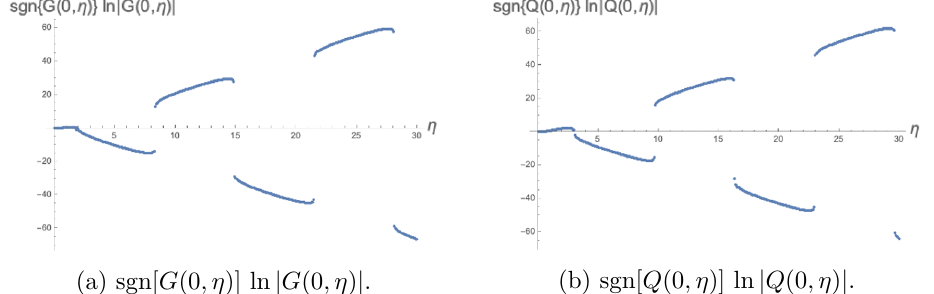
Figure 3 . Plots of sgn[ G (0 ; (cid:17) )] ln j G (0 ; (cid:17) ) j and sgn[ Q (0 ; (cid:17) )] ln j Q (0 ; (cid:17) ) j versus (cid:17) for N f = 3 and N c = 3. Both graphs result from numerical computations with the step size (cid:1) (cid:17) = 0 : 075 and (cid:17) max = 30.